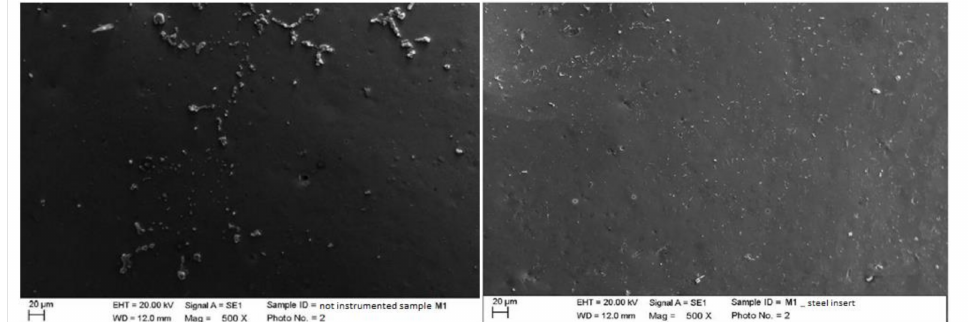
Figure 14. Instrumented ceramic sample M1 with steel insert (500 × ). Comparison before/after instrumentation.